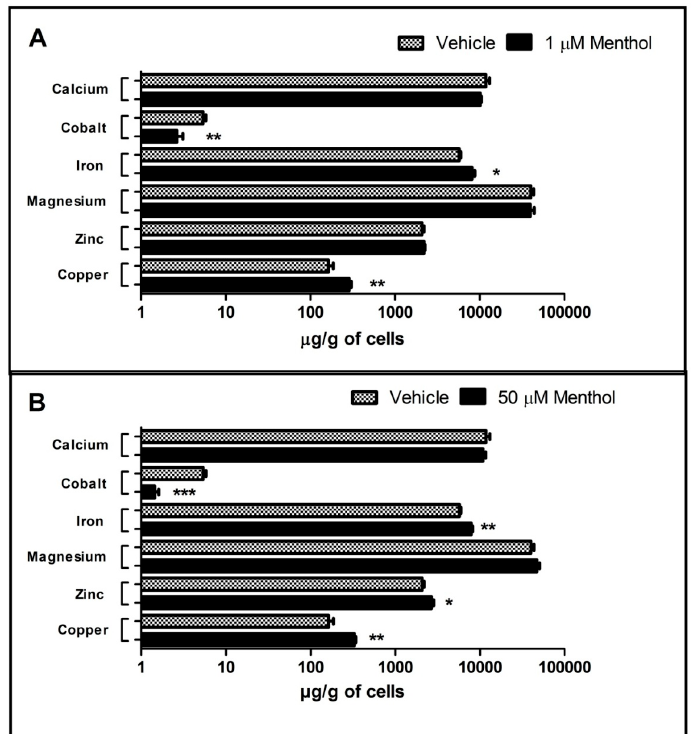
Figure 3. E ff ect of menthol treatment on. ( A ) Metal concentration (Ca, Co, Fe, Mg, Zn, Cu) in 3T3-L1 Figure 3. Effect of menthol treatment on.( A ) Metal concentration (Ca, Co, Fe, Mg, Zn, Cu) in 3T3-L1 cells at 1 µM dose; ( B ) Metal concentration (Ca, Co, Fe, Mg, Zn, Cu) in 3T3-L1 cells at 50 µM dose; n = 3–5; All the values are expressed as mean ± S.E.M; Analysis was carried out by student unpaired t - test ; * p < 0.05 , ** p < 0.01 , *** p < 0.001.